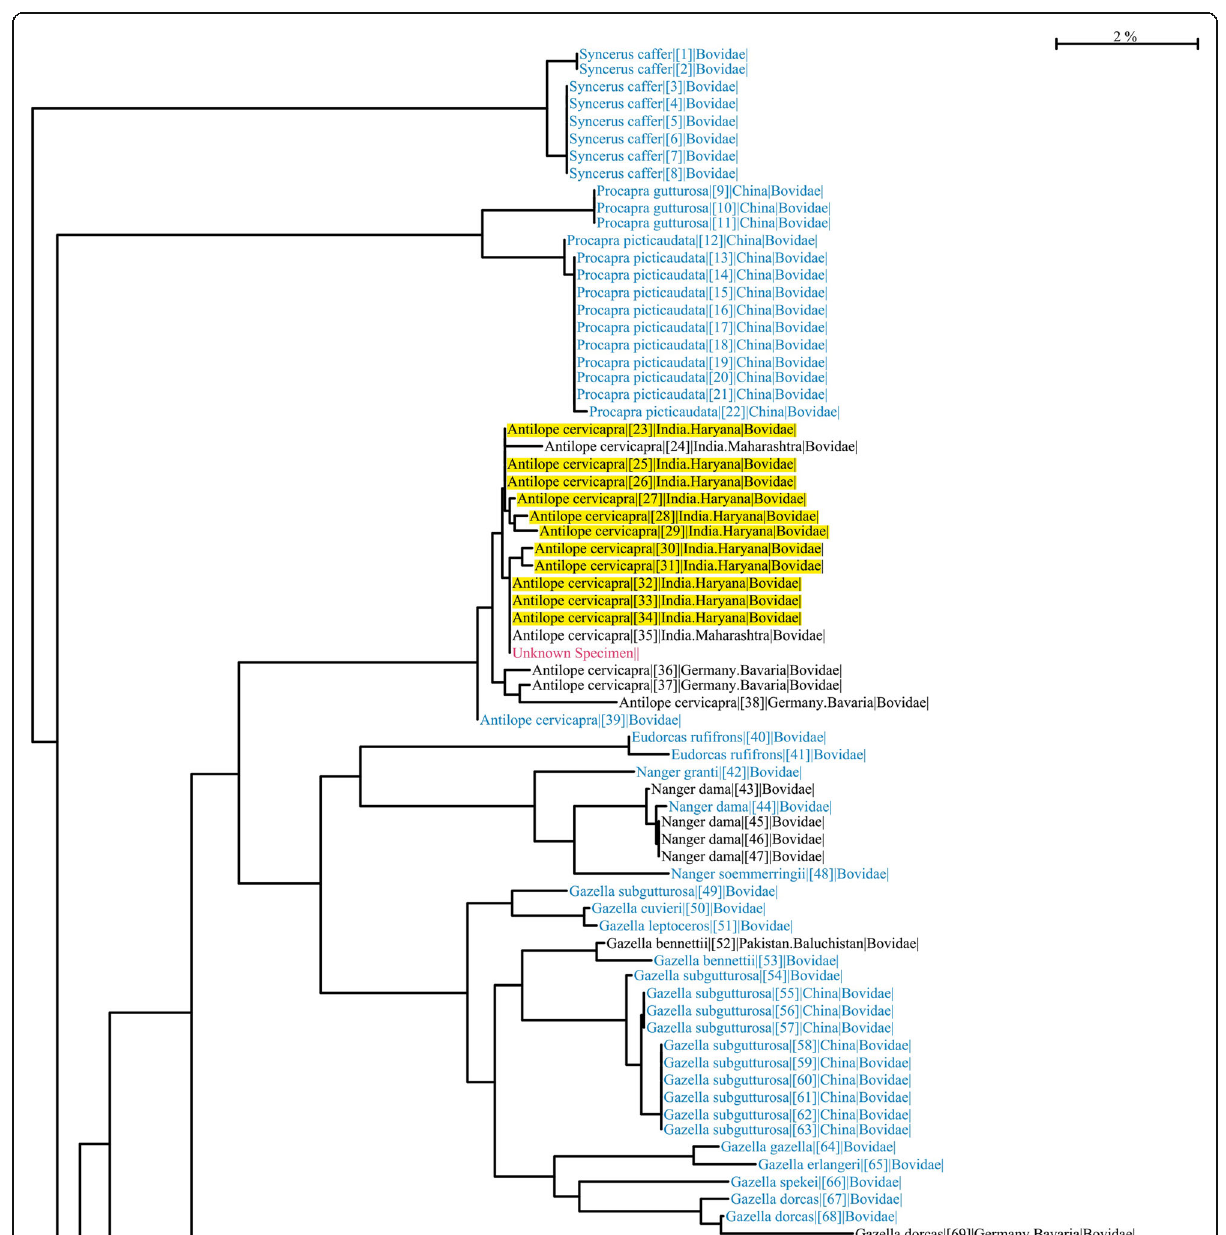
Fig. 2 Neighbour-joining phylogenetic tree (K2P distance) based on COI barcode generated in BOLD database (BOLD, www.barcodinglife.org). Highlighted yellow color shows the submitted sequences of Blackbuck from the present study in